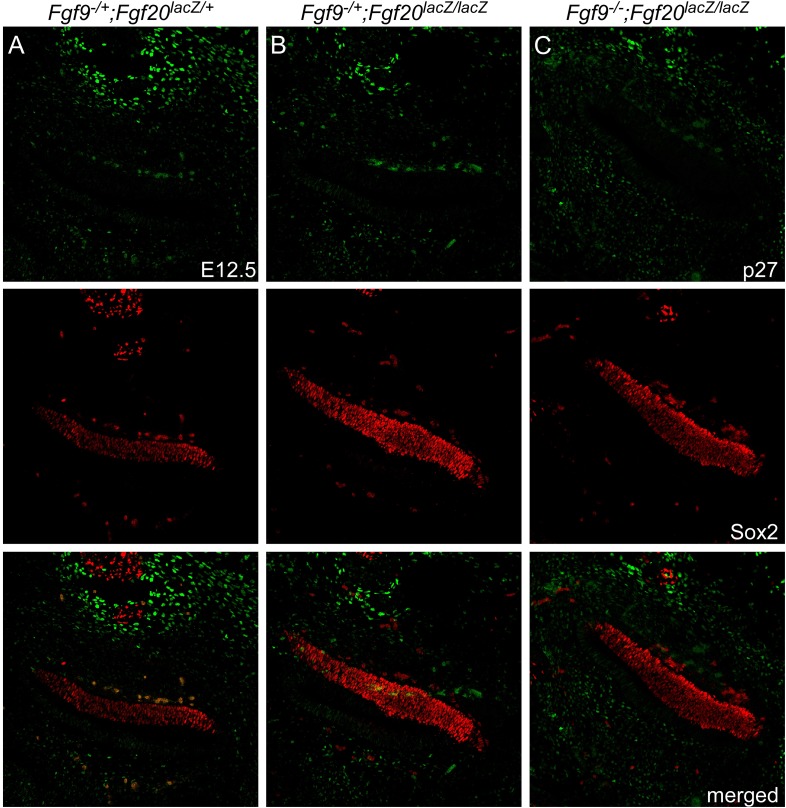
Fgf9 and Fgf20 loss do not cause premature cell cycle exit.(A–C) p27 (green) and Sox2 (red) co-immunostaining of E12.5 Fgf9−/+;Fgf20lacZ/+ (A), Fgf9−/+;Fgf20lacZ/lacZ (B), and Fgf9−/−;Fgf20lacZ/lacZ (C) embryo sections.